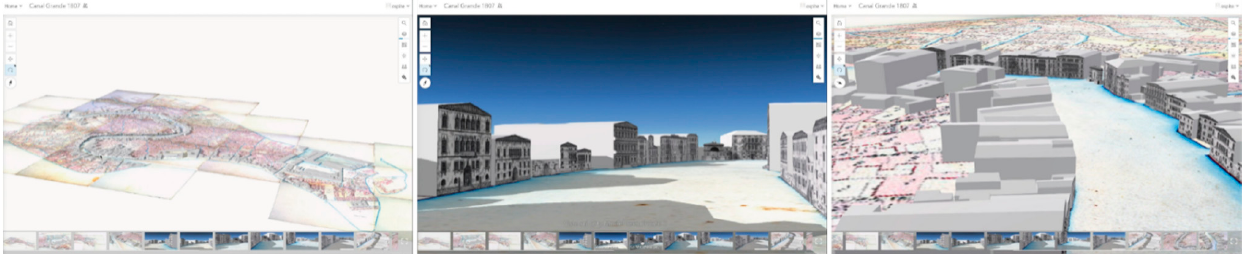
Figure 25. Views of the WebGIS.